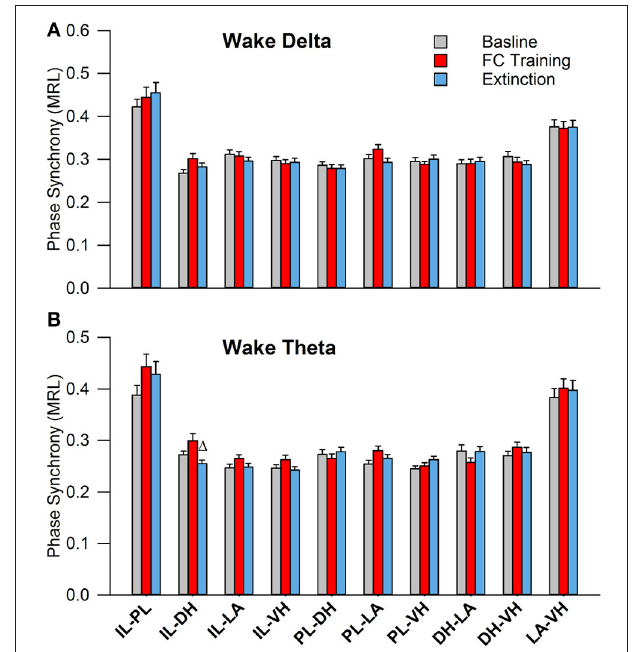
FIGURE 5 | Synchrony during Wakefulness following Fear Conditioning and Extinction. Bar plots displaying delta (A) and theta (B) synchrony during wakefulness following fear conditioning (red) and extinction (blue), where 1.0 is perfect synchrony and 0 is no synchrony. As expected, neither delta nor theta rhythms change during wakefulness following experimentation. Interestingly, the IL shows significantly increased theta synchrony with the DH following extinction compared to fear conditioning, which contrasts with the current model of the division of labor within the medial prefrontal cortex (Giustino and Maren, 2015 ). 1 denotes significant difference ( p < 0.05) compared to fear conditioning. IL, infra-limbic; DH, dorsal